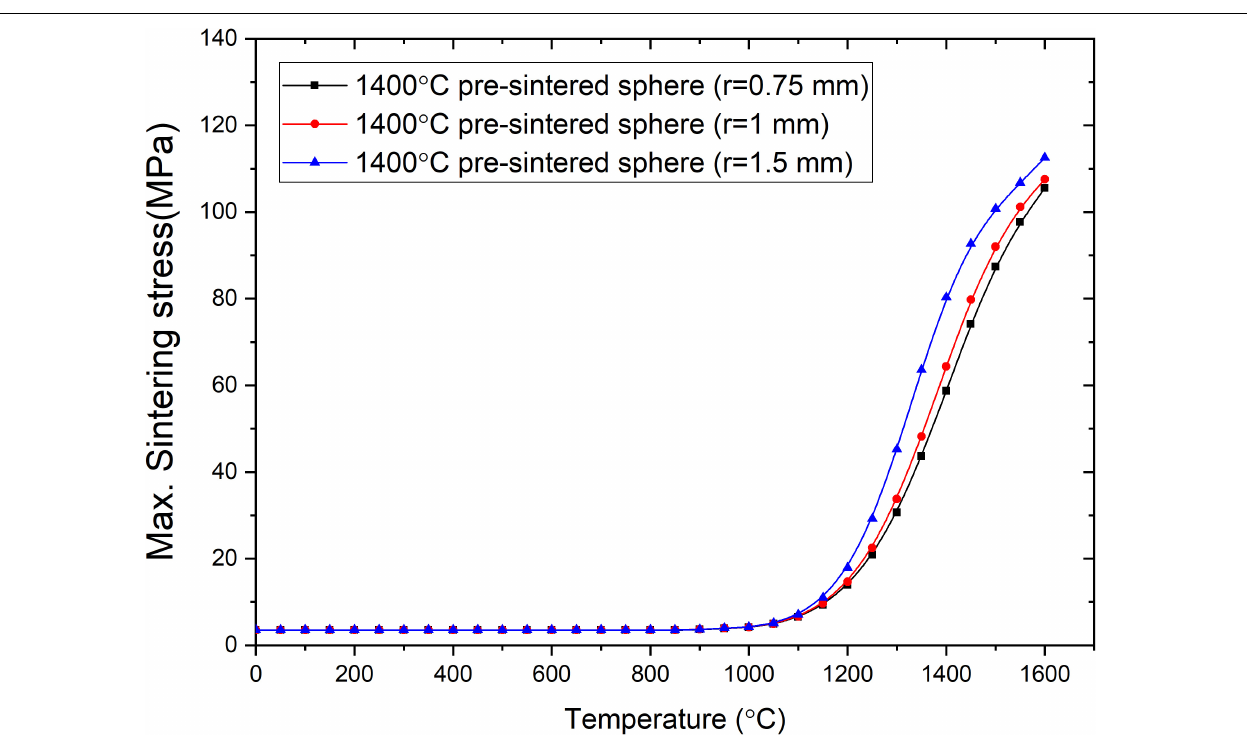
Frontiers in Energy Research |